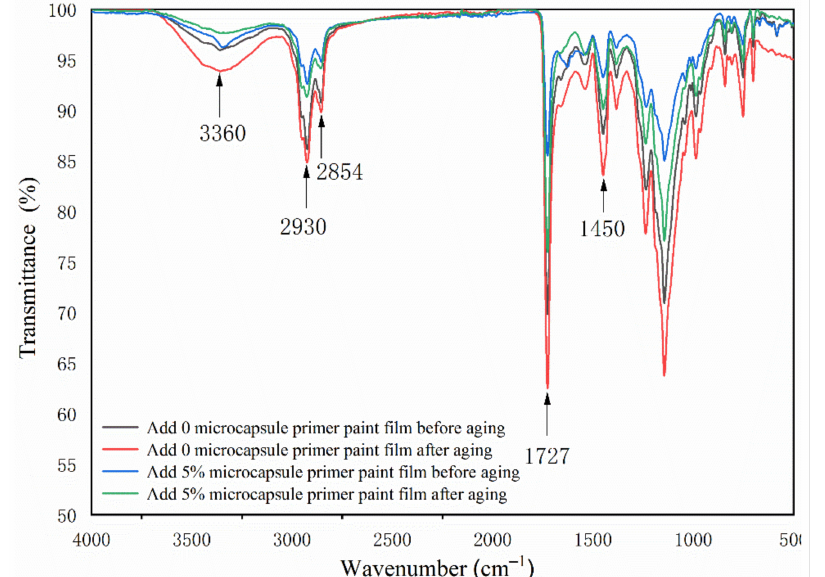
Figure 11. The FTIR of coatings with different concentration of microcapsules before and after UV aging.